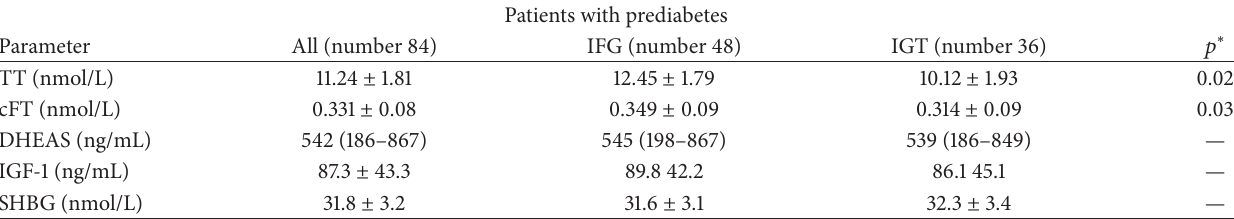
Table 2: Anabolic hormones concentrations in patients with PD after dividing according glycemic control disorders. Patients with